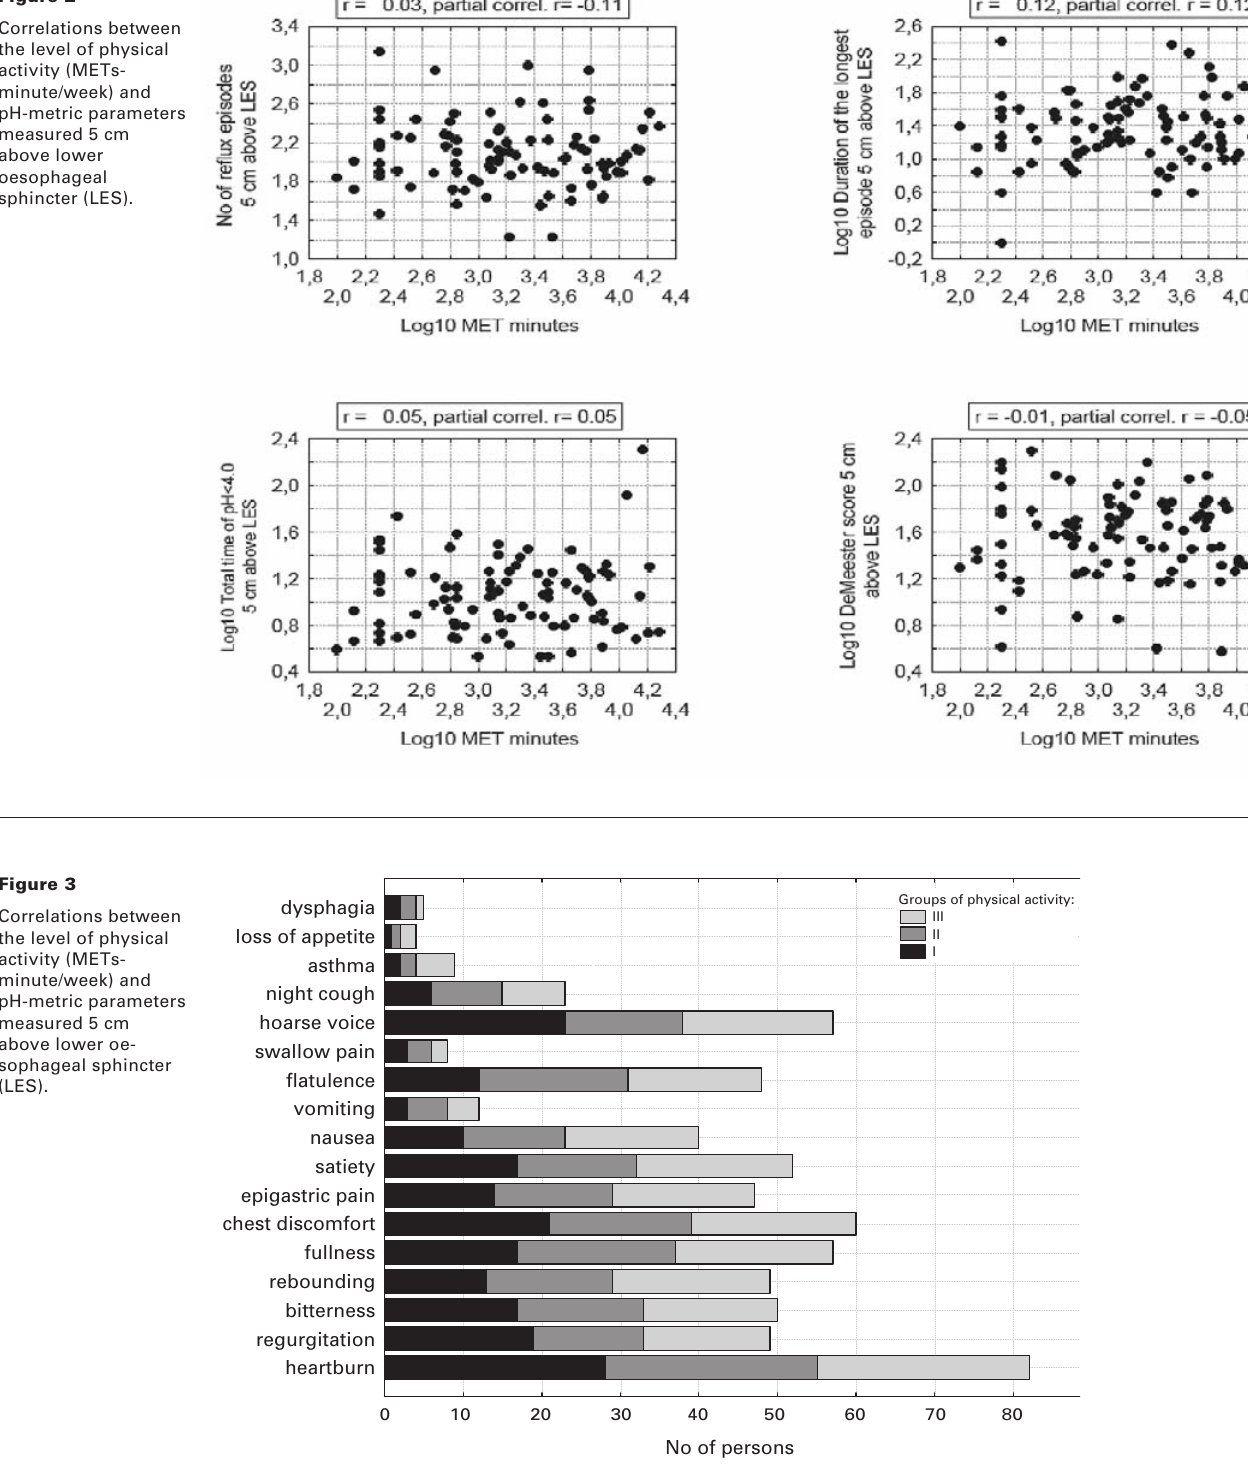
Correlations between the level of physical activity (METs- minute/week) and pH-metric parameters measured 5 cm above lower oesophageal sphincter